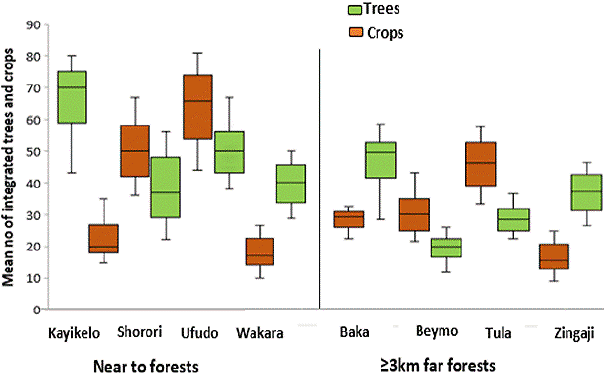
Fig. 3. Mean numbers of naturally grown and planted tree species per study site, recorded (A) in homegardens, (B) in crop fields, (C) along farm boundaries, and (D) in riparian areas.